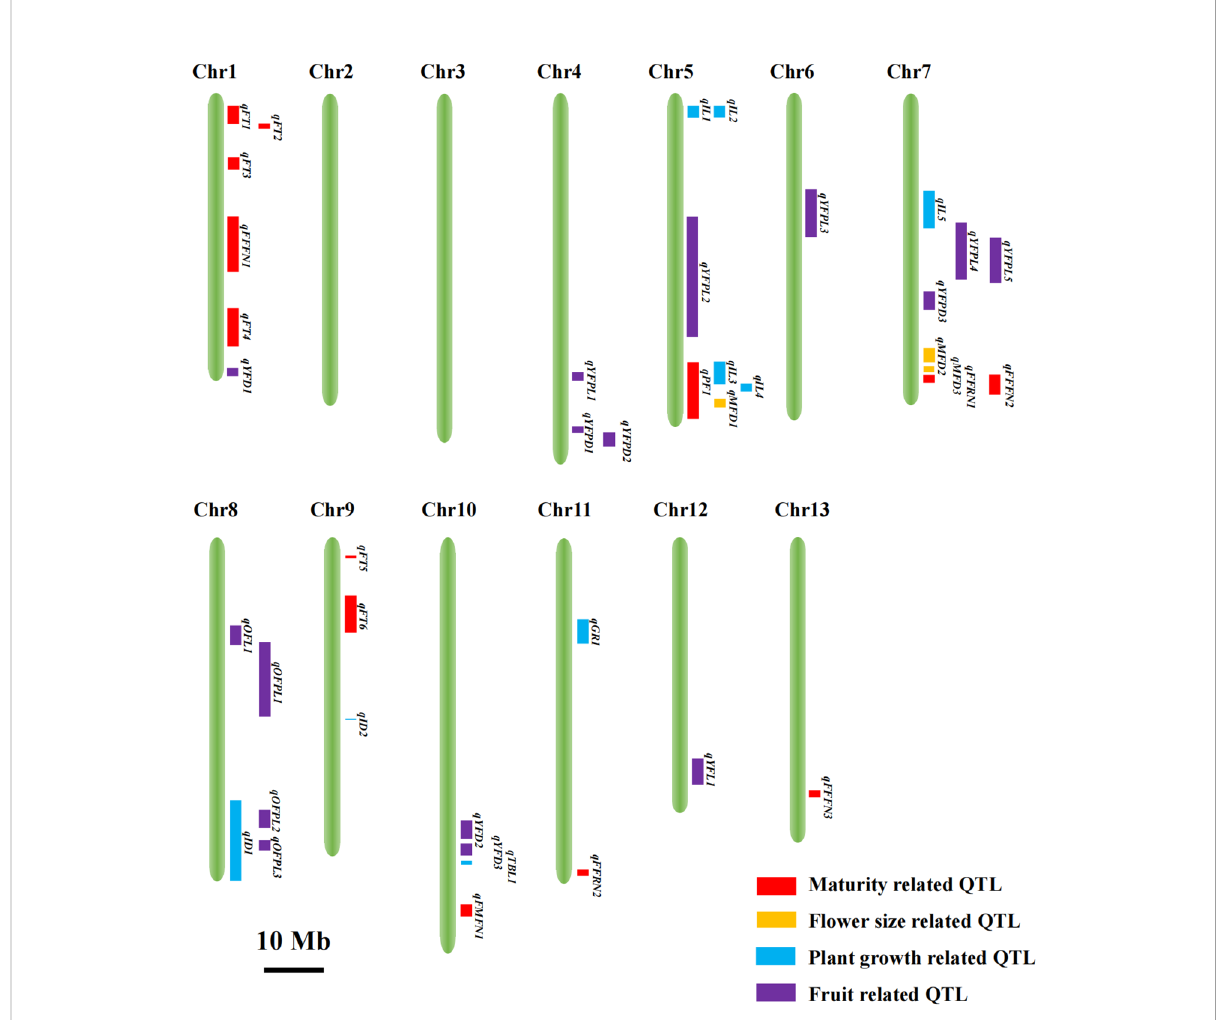
FIGURE 2 Visualization of the chromosomal locations of the 40 QTLs. The red, yellow, blue and purple rectangles represent the QTLs related to maturity, fl ower size, plant growth and fruit, respectively. The 10 Mb bar indicates the size of regions in the reference genome Luffa acutangular S1174. Chr,